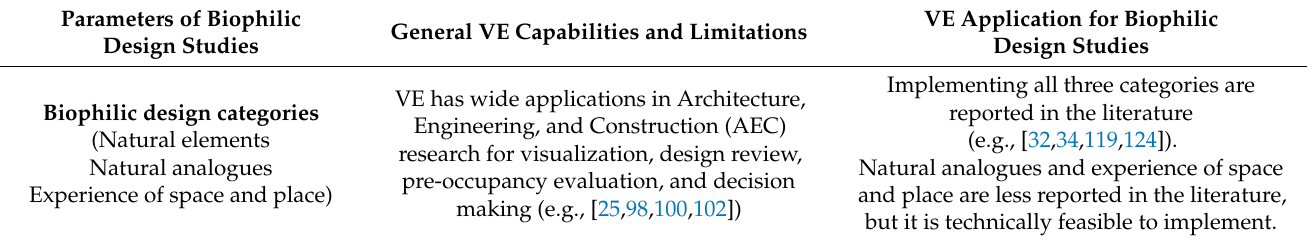
Table 2. Virtual Environment (VE) applications for biophilic design studies and future